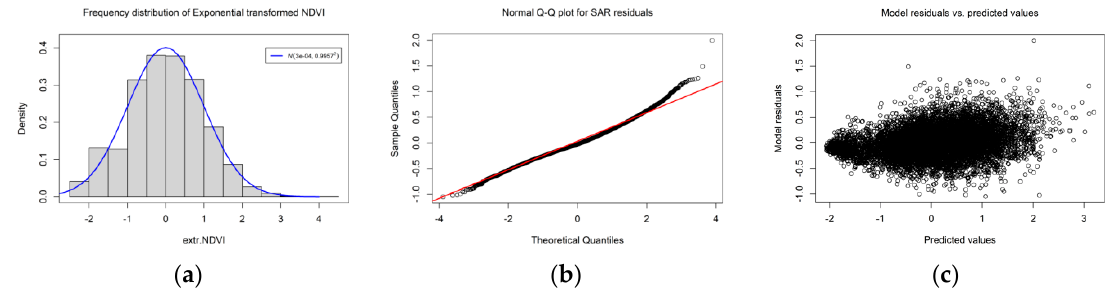
Figure A10. Improved normality of transformed normalized difference vegetation index (NDVI) and regression residuals: ( a ) a histogram of the Exponential transformed NDVI; ( b ) a Q-Q plot of the SAR model residuals; and, ( c ) a scatter plot of residual-predicted values for assessing the homoscedasticity of model residuals.